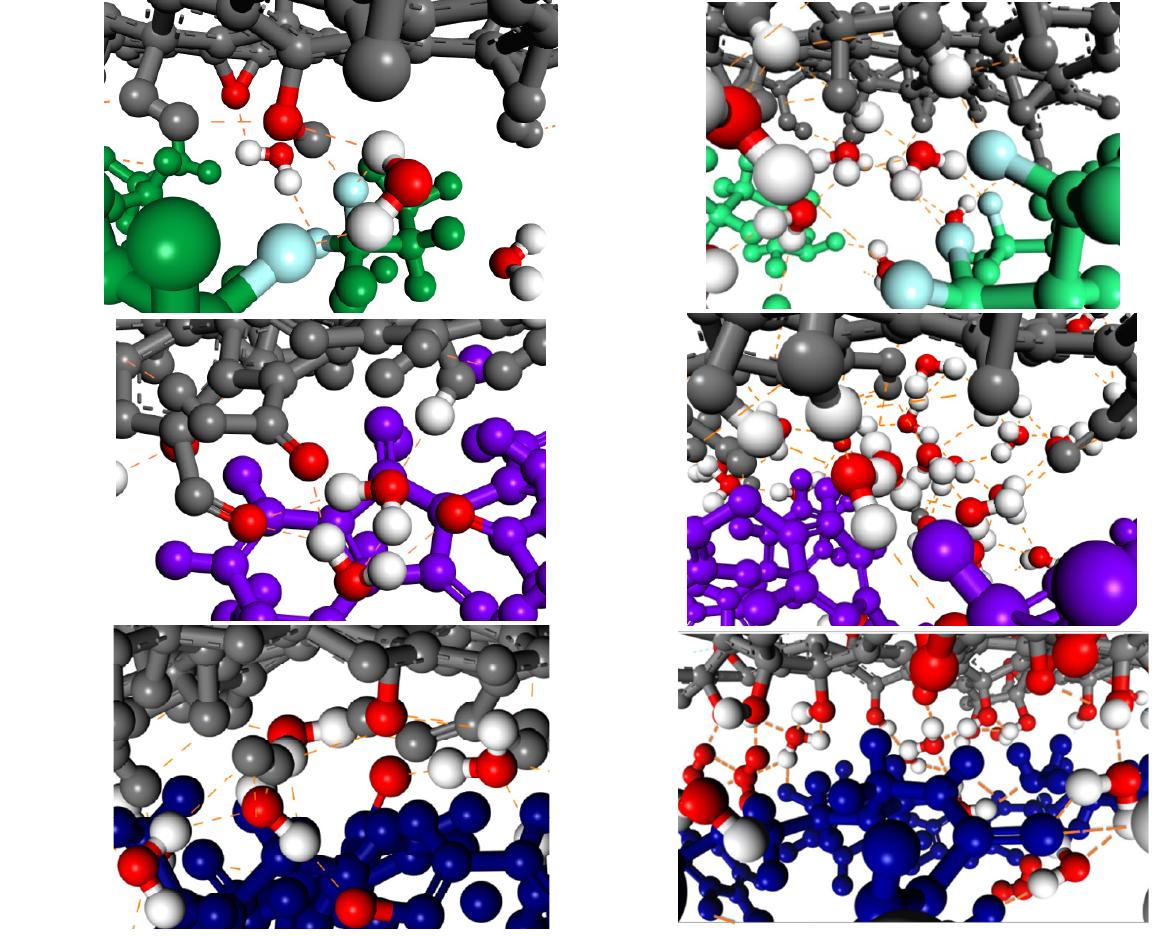
Figure 4. Examples of hydrogen bonds between polymer–water–GO in the lower layer of GO at the beginning of the simulation (left column) and at the end (right column). GO in colored in gray, PAI in purple, PVDF in green, and crosslinked PAI in blue. Some atom types are colored differently in order to highlight their atom type: oxygen in red, hydrogen in white, fluorine in light blue. The orange dotted line represents the hydrogen bonds.